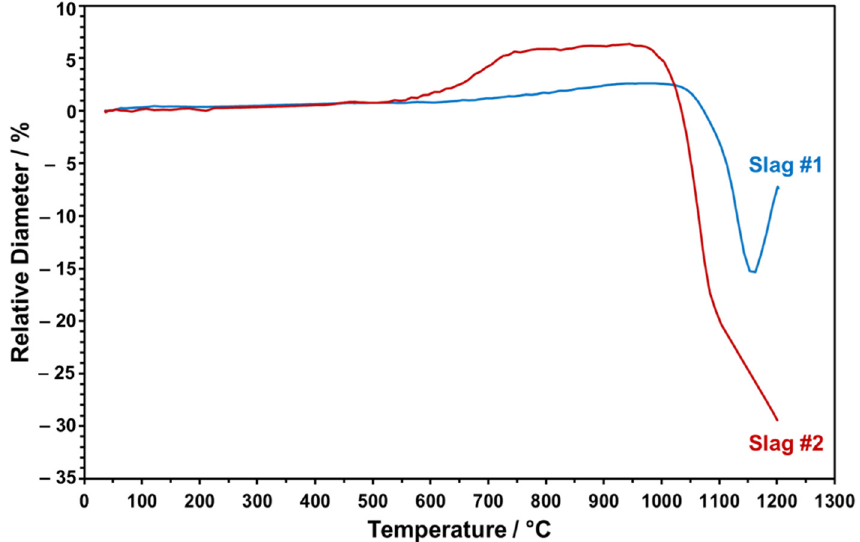
Figure 11. The relative change in the diameters of the slag particles at elevated temperatures meas- ured by optical dilatometry. by optical